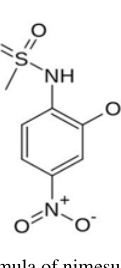
It is officinal according to Pharmacopoeia Europea 7, and appears as yellowish odorless powder soluble in acetone and almost completely insoluble in water. 9 The data from the available literature showed that its acidity constant (p K ) ranges from 5.9 to 6.5. Nimesulide hydro- a solubility of 0.01 mg/ml strongly depends on pH value of the medium. 10 Nimesulide molecule contains no assyme- trical carbon atoms and lacks optical activity, as well as potential for chirality and isomery. It has been reported earlier that solubility of this drug under physiological pH range varies from 0.0078 mg/ml at pH 1.2 to 0.0829 mg/ml at pH 7.4. 1 Nimesulide has two polymorphic forms I and II, but only Form I is commercially available, due